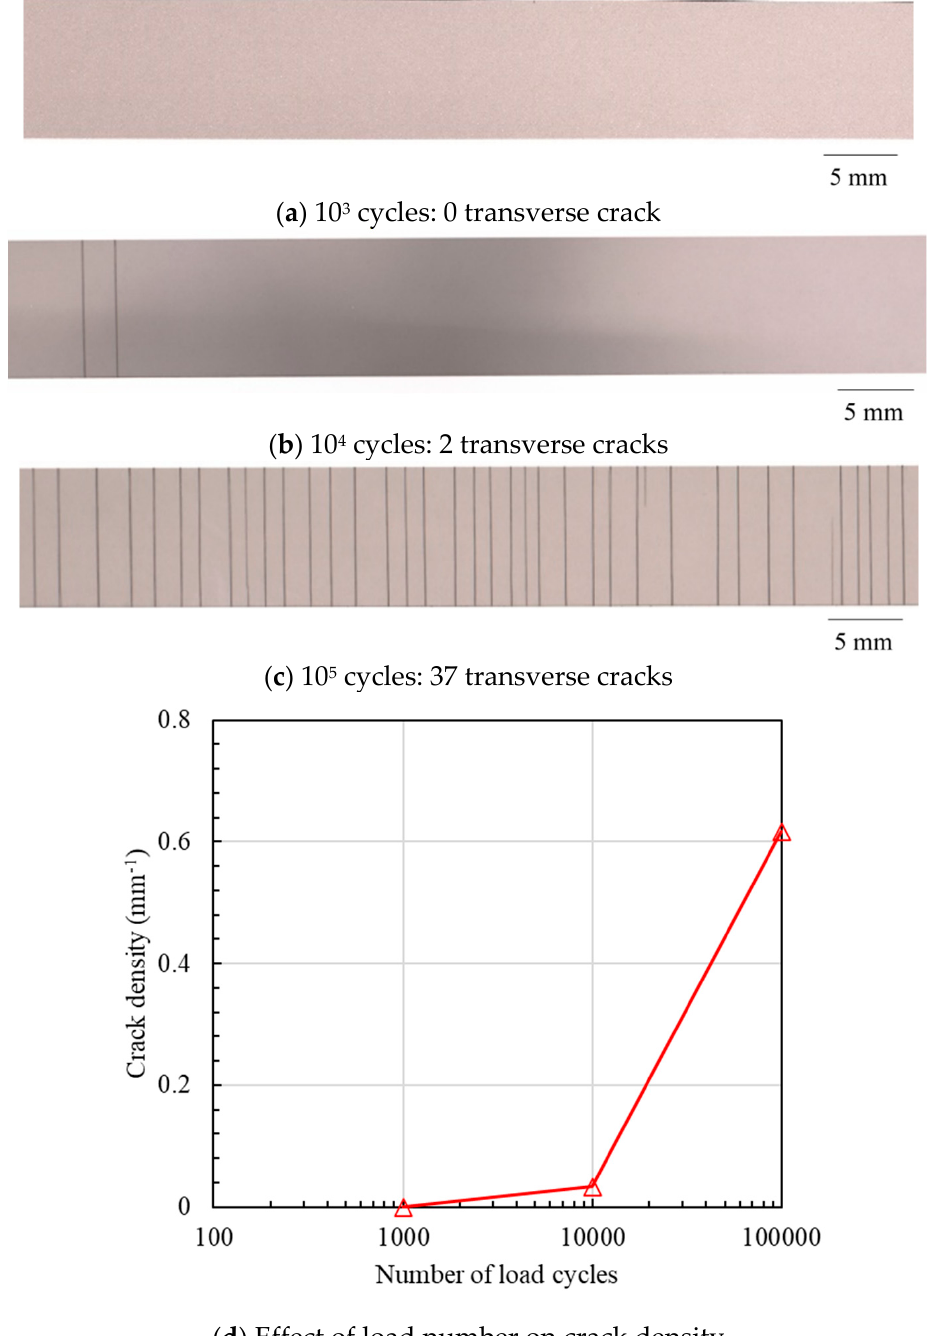
Figure 5. Transverse crack distribution under various cyclic load numbers at a maximum stress of 30% of the tensile strength.